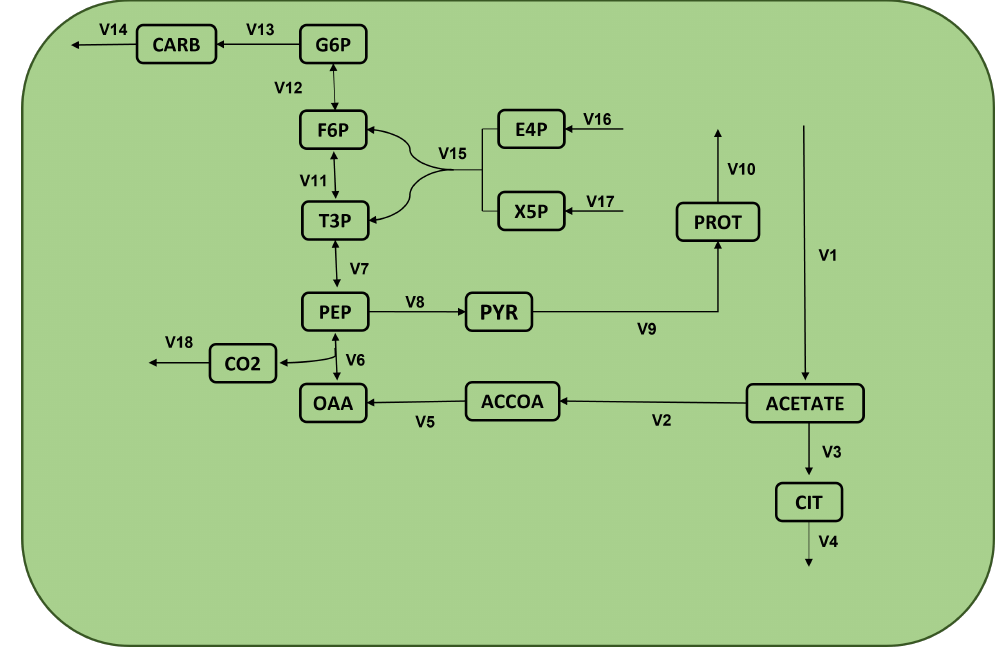
Figure 7. Metabolic network of Chlamydomonas reinhardtii